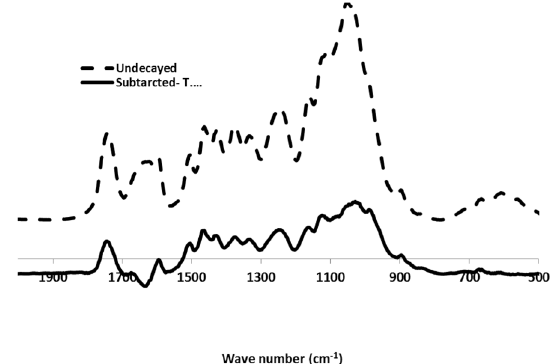
Figure 2 - Subtracted FT-IR spectra of the white-rot decayed hornbeam wood in naturally infected ( in vivo ) by Trametes versicolor .